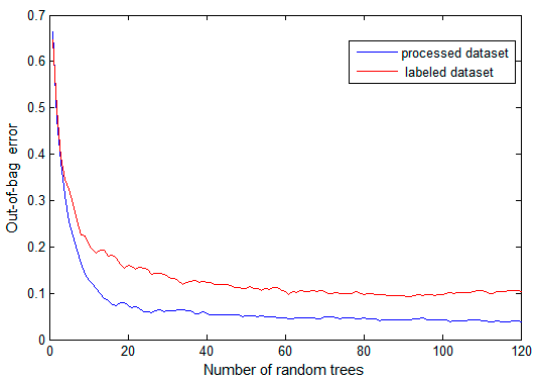
Figure 7. Out-of-bag error of the processed and original labeled datasets.